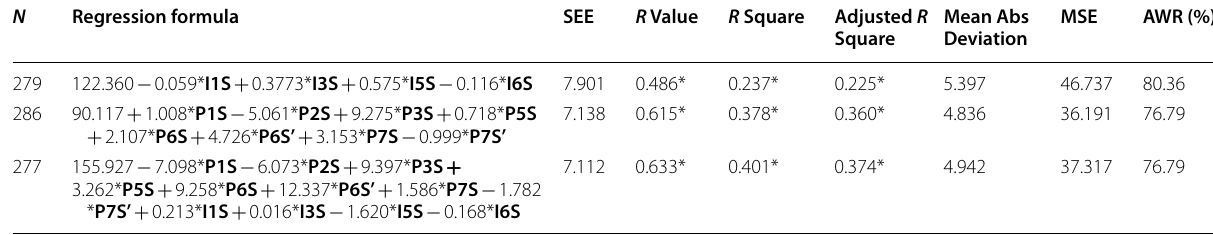
Table 9 Correlation and regression statistics for combination of parameters and indexes of sacral morphometric against stature in validation